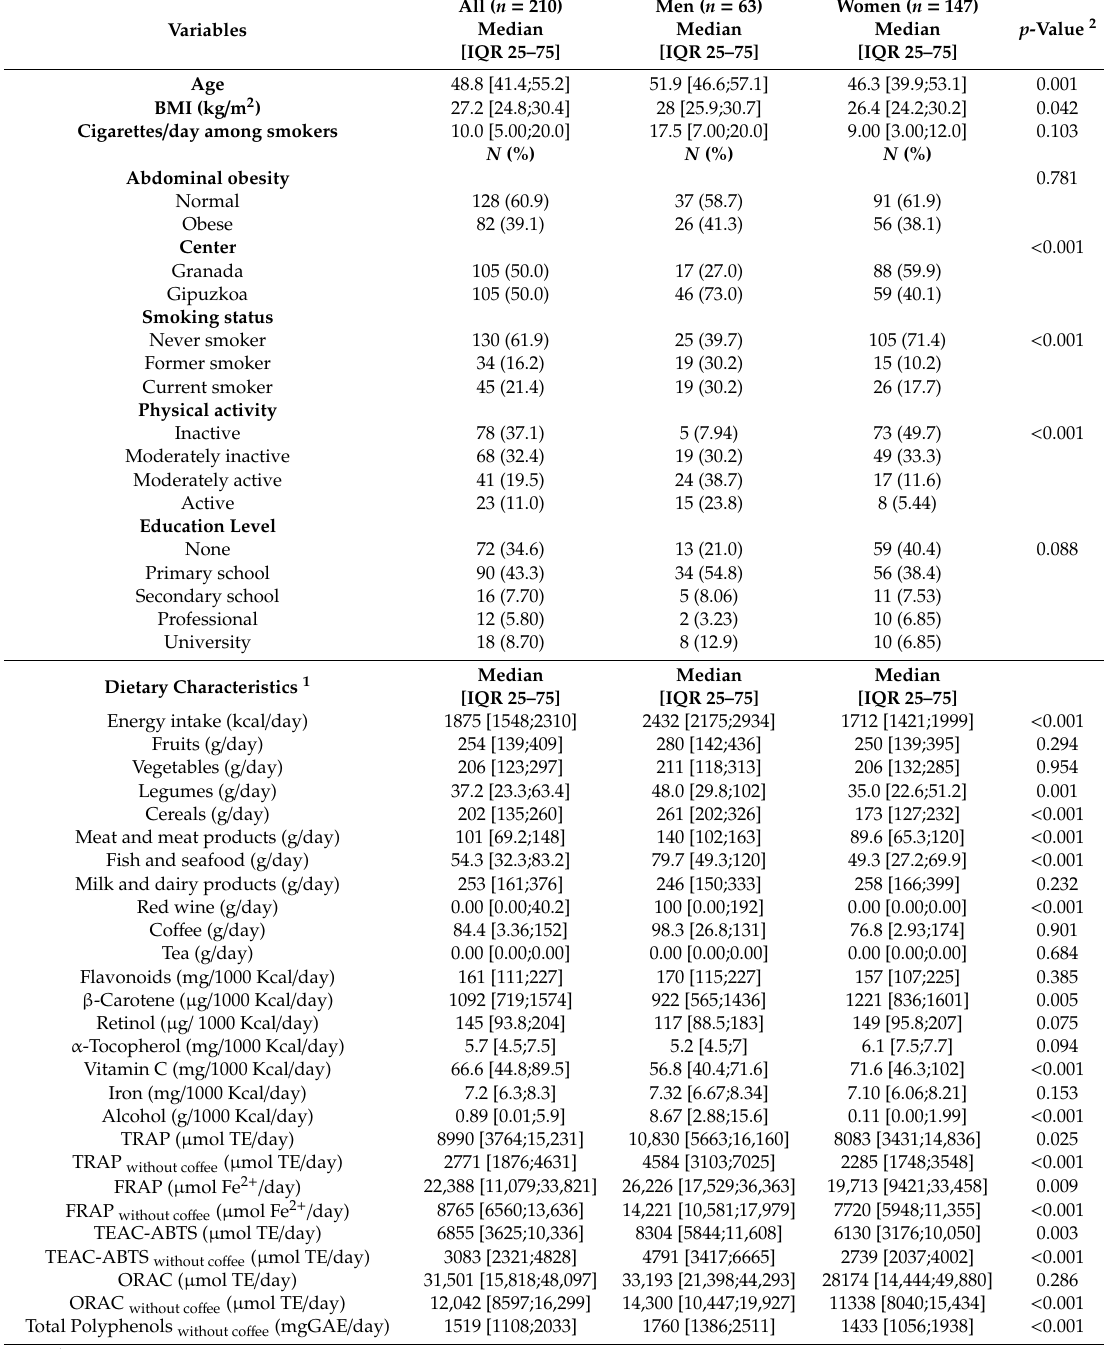
Table 1. Baseline characteristics of the study sample (63 males and 147 females) within the EPIC Granada–Gipuzkoa